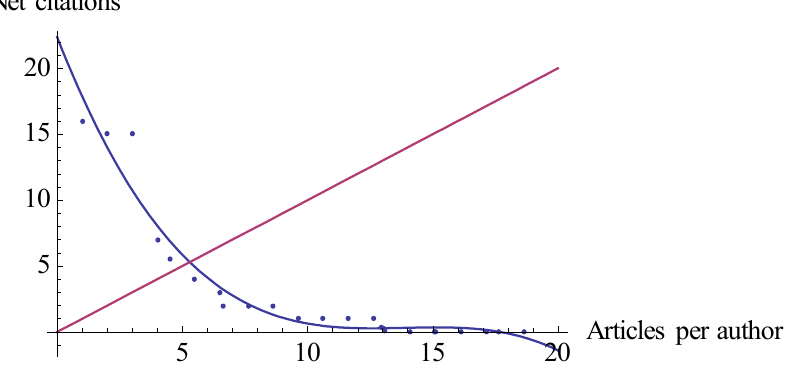
Figure 2. Least-squares cubic interpolation fitting for the H index per author (i.e., scientific core production): H ctn = 5.28 ( R 2 = 0.95; regression sum of squares = 553; sum of squares for the residuals = 30; F (4, 20) = 120 ( p < 0.001) with 4 parameters and 24 observations). The red increasing linear line represents y = x ; the blue decreasing line represents the fitted curve. Abbreviations: c = cubic interpolation; t = total number of publications and citations in the period 1995 to 2016; n = net citations.